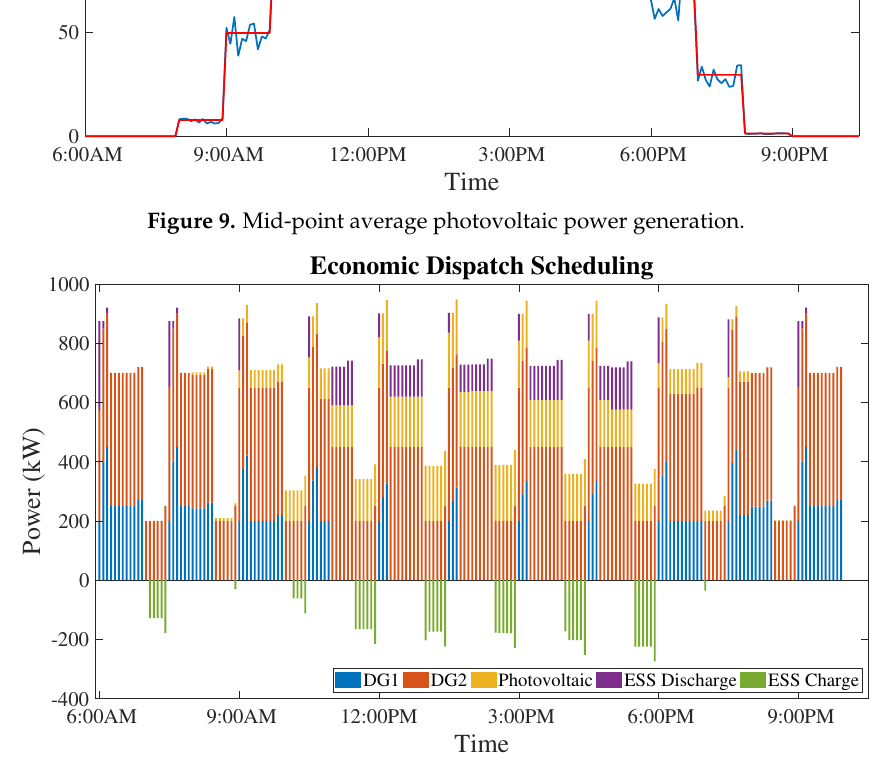
Figure 10. Economic dispatch for ferry generation scheduling (case study 1).